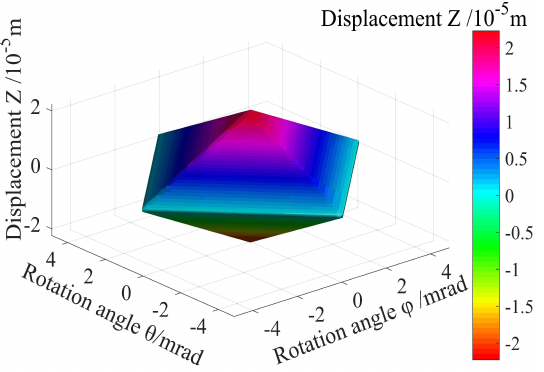
Figure 12. Three motion ranges of the flexible piezoelectric nano-positioning stage under − 90 V ∼ + 90 V